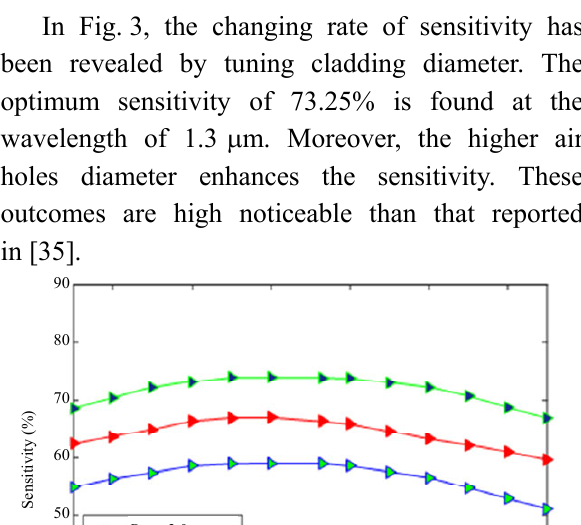
Fig. 2 Variation of sensitivity verses applied wavelength due to tuning the cladding pitch when other parameters are kept constant.